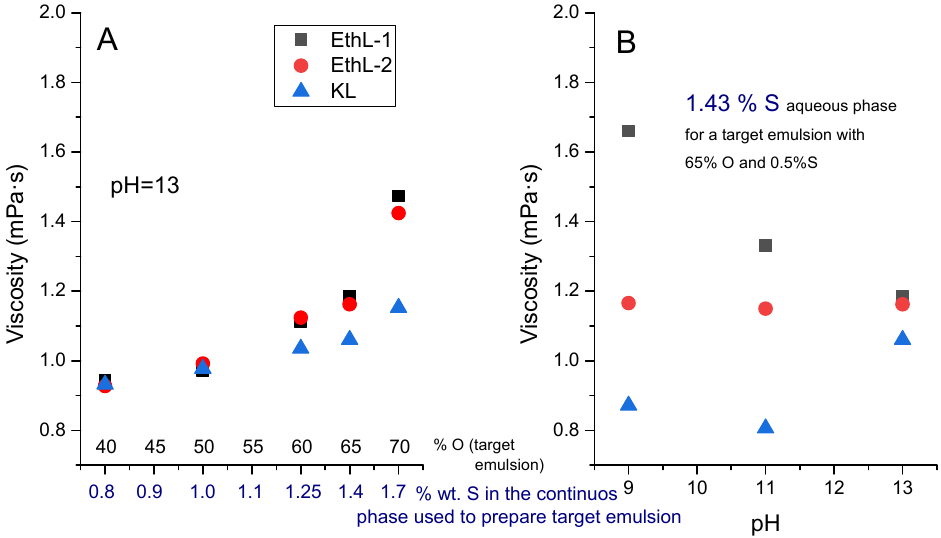
Figure 1. Viscosity of the emulsion continuous phase as a function of: ( A ) selected oil concentration of emulsion prepared at pH = 13; ( B ) emulsification pH for emulsions containing 65% O.